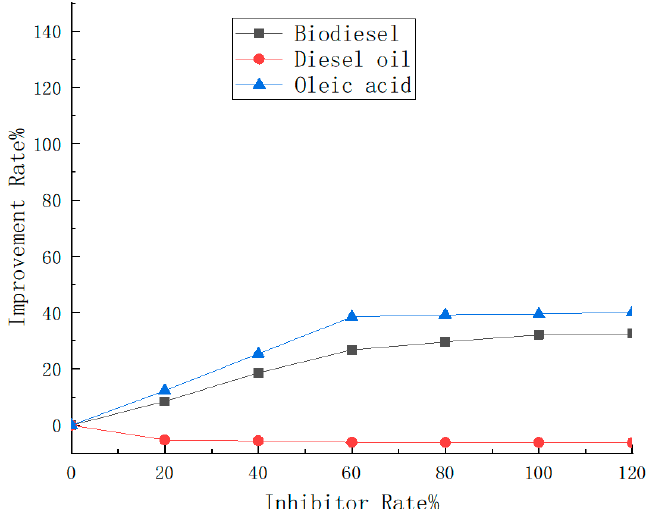
Figure 7. The improvement rate of each dispersant at different concentrations.